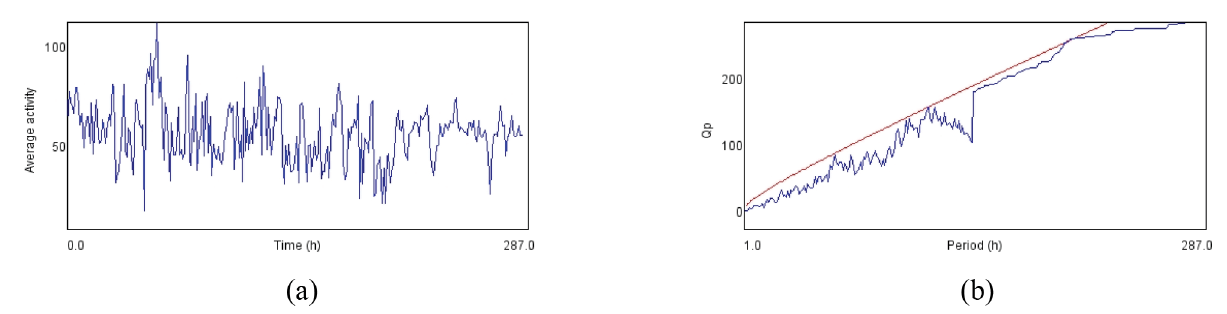
FIGURE 6S - (a) and (b) shows the average activity pattern and chi-square periodogram respectively for PD flies exposed to luteolin (50 µM).